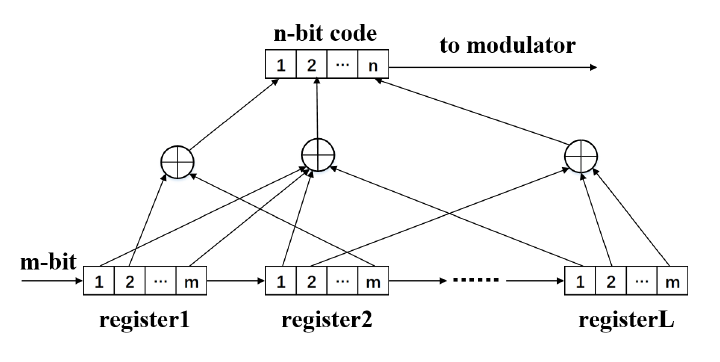
Figure 1. Structure of the convolutional code